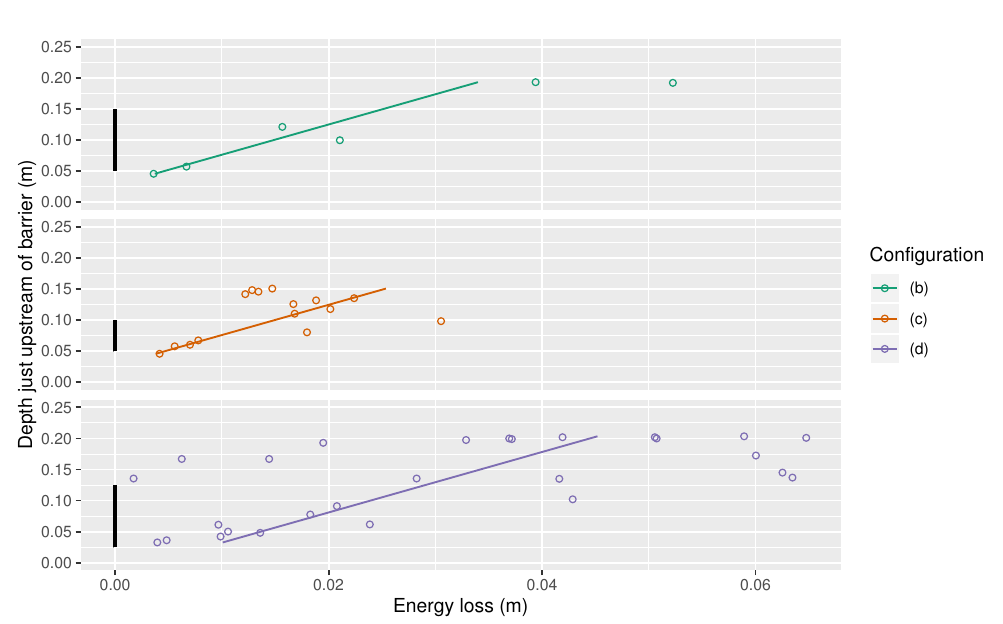
Figure 5. Estimated measured energy losses (circles) and the regression Equation (38) (lines) for each barrier configuration. Only includes free-flow scenarios where the depth is greater than the gap underneath the